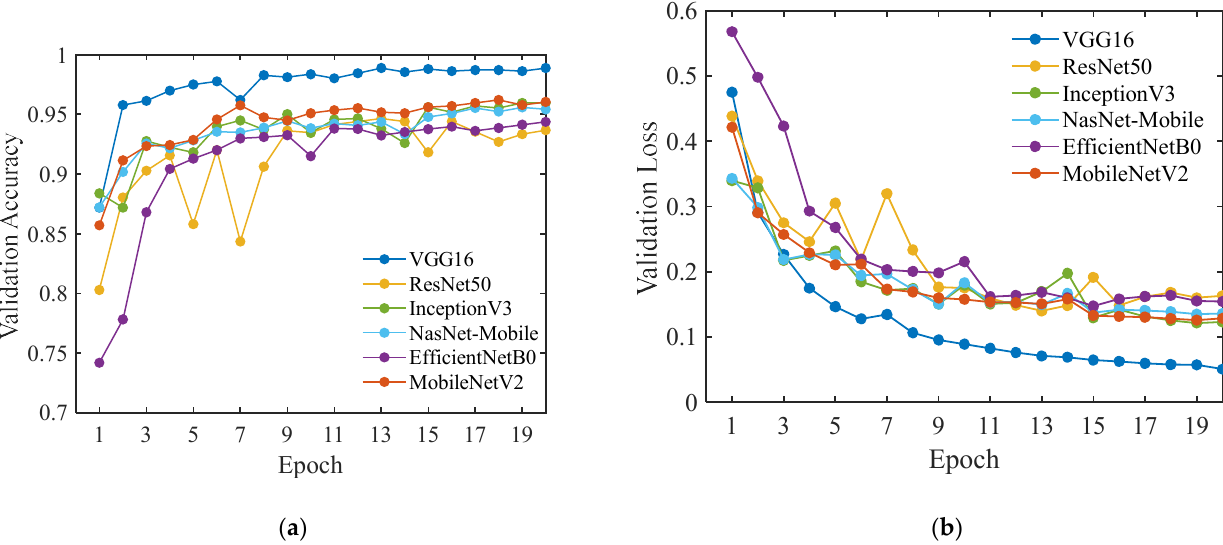
Figure 4. The validation ( a ) accuracies and ( b ) losses of VGG16, ResNet50, InceptionV3, NasNet- Mobile, EfficientNetB0, and MobileNetV2.